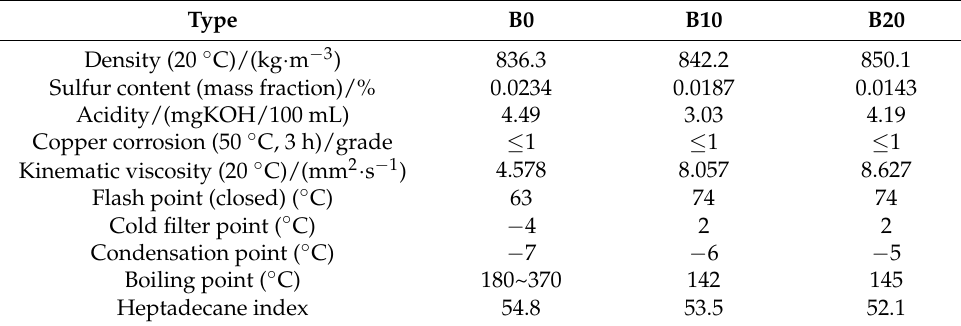
Table 3. The properties of biodiesel with different